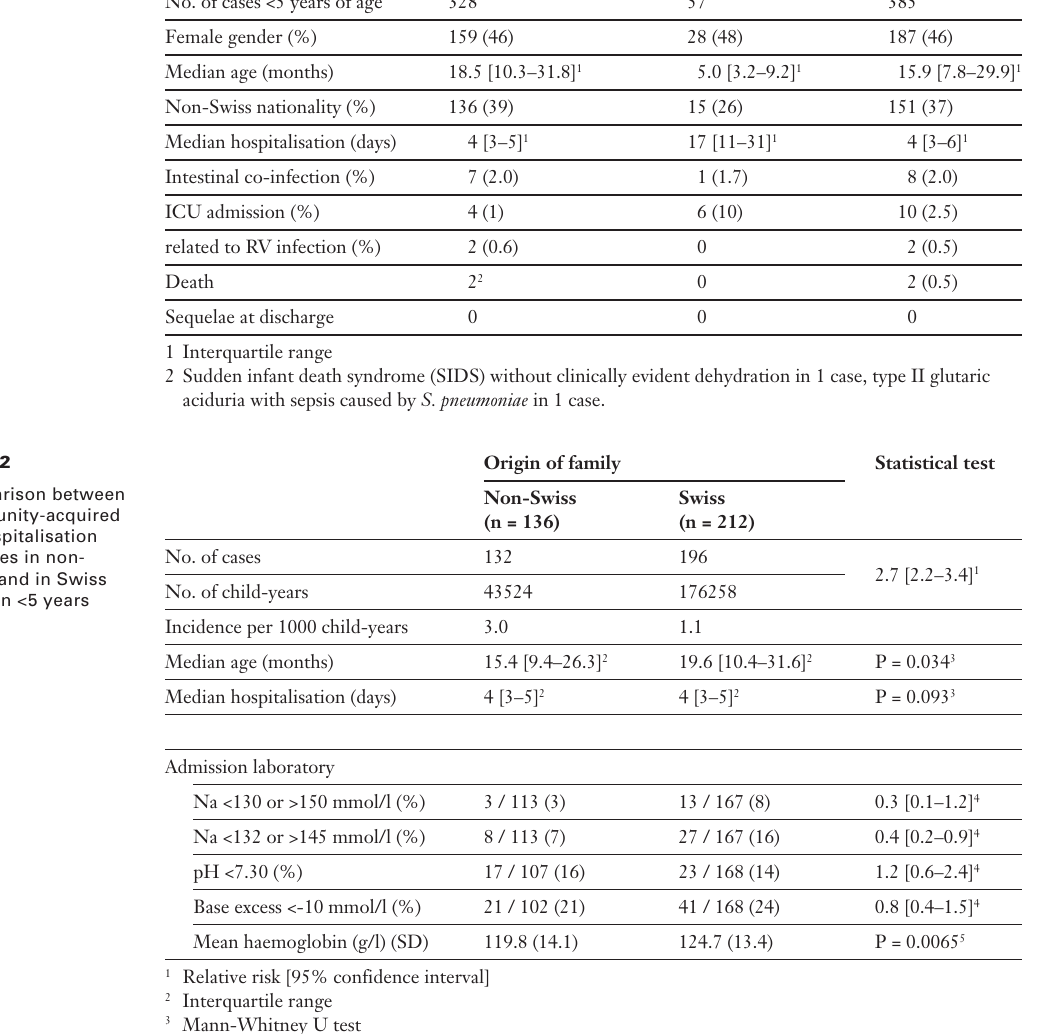
Seasonality of RV hospitalisations In 1999, 2000, 2001, 2002, and 2003 there were 62, 70, 111, 101 and 62 RV hospitalisations respectively. Figure 2 depicts the seasonal distribu- tion of RV cases during the study period. In the